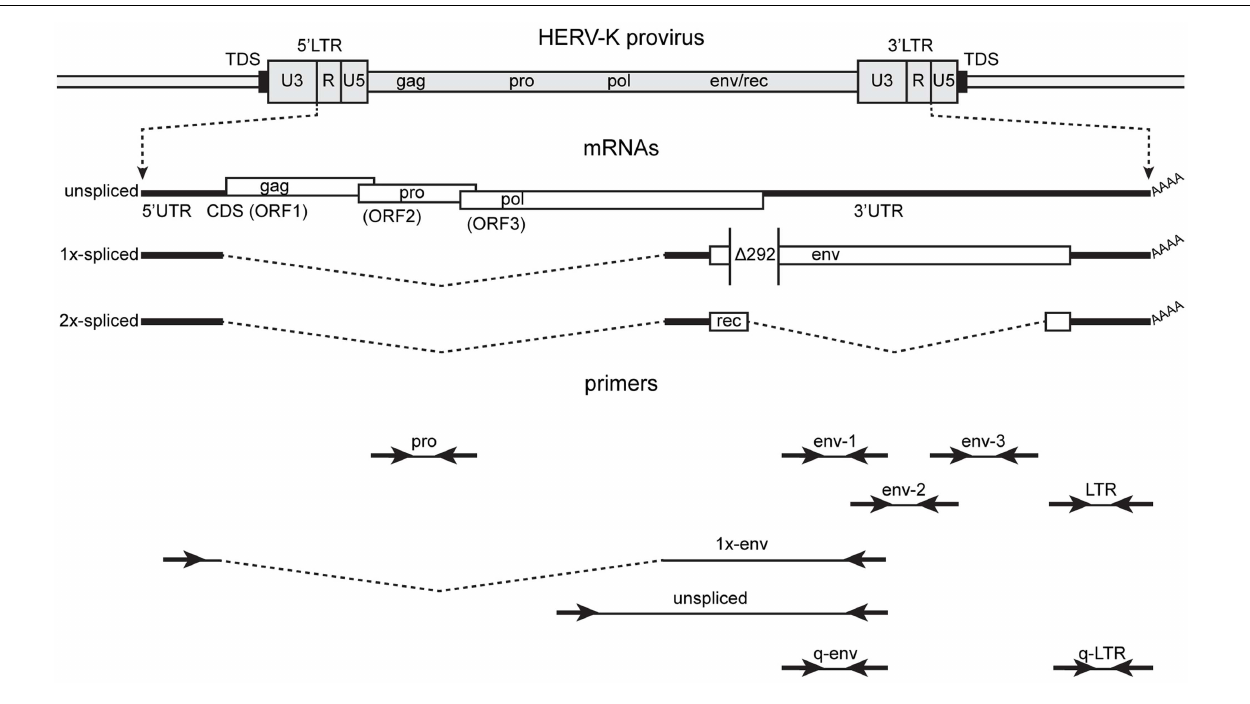
FIGURE 2 | Structure of the HERV-K genome and spliced mRNAs showing the primers used for reverse transcription and PCR . A genetic map of a HERV-K provirus (darker gray) inserted into host genome (lighter gray) is shown with target duplicated sequence (TDS) indicated as black boxes.The unspliced primary viral transcript, 1 × -spliced env mRNA and 2 × -spliced rec mRNAs are shown below the viral genome with 3 (cid:48) poly(A) tails